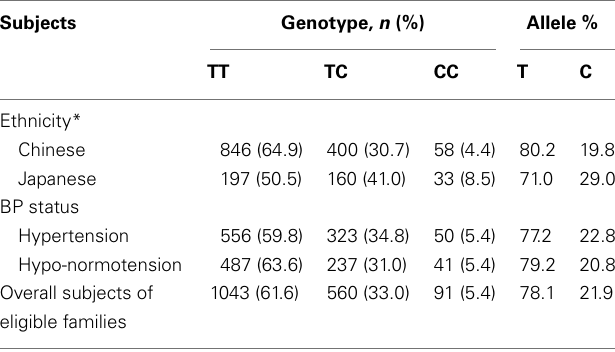
Table 2 | Distribution of genotypes and alleles for the ETART323C polymorphism in studied subjects